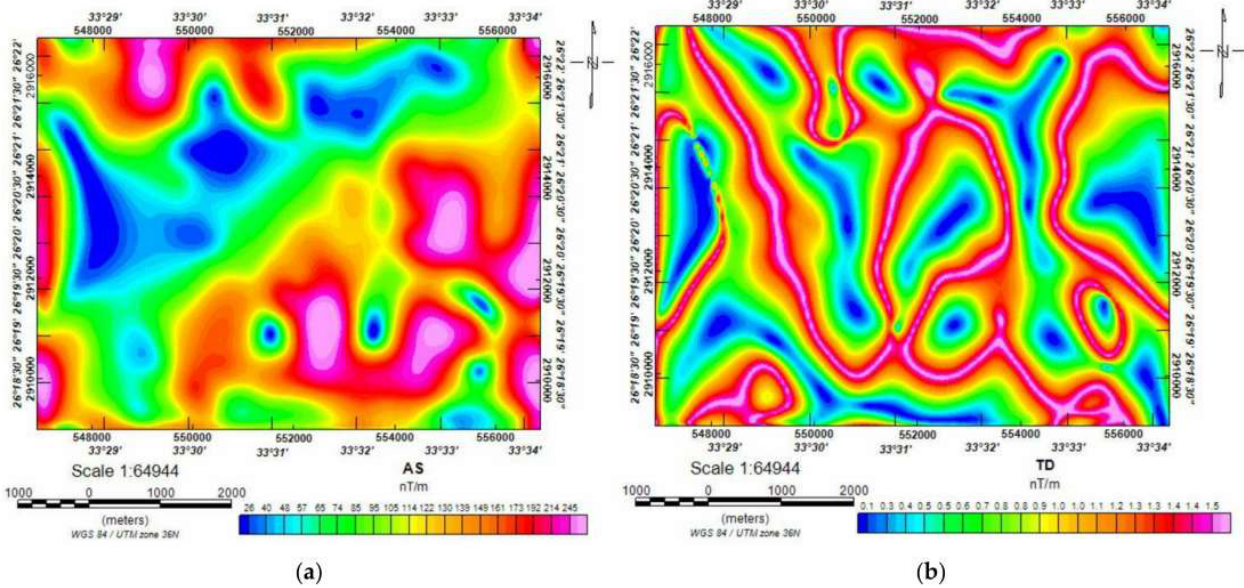
Figure 9. ( a ) Map of the analytical signal (AS) of the research area. ( b ) Tilt-derivative (TD)